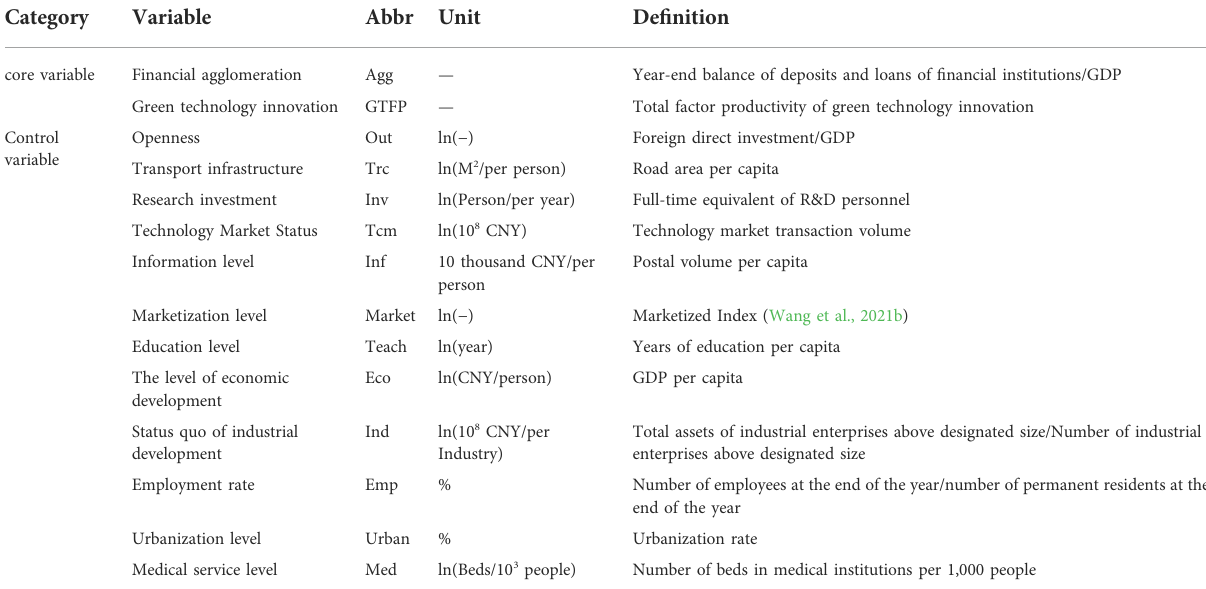
TABLE 2 Indicator types and symbol